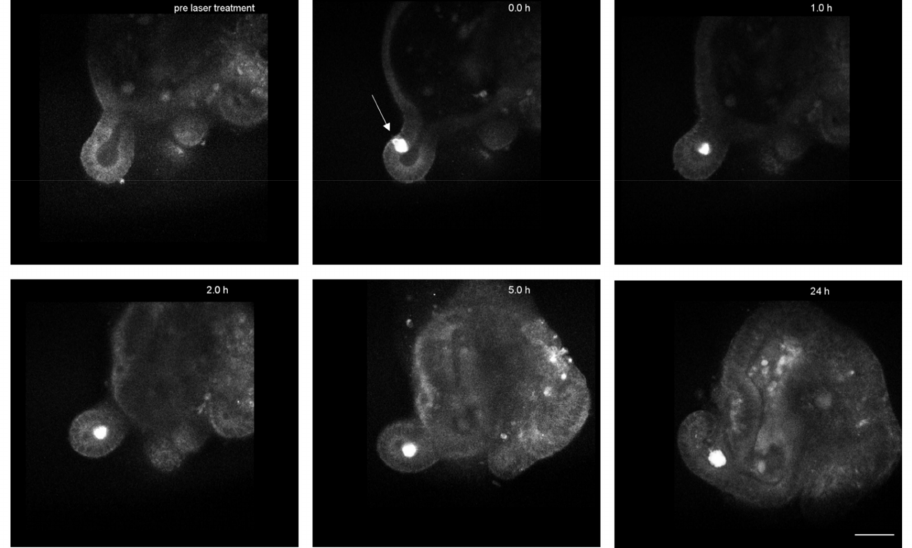
Figure A2. Time series of a single cell ablation in an unstabilised colonoid. The ablation site is labeled with a white arrowhead. One hour before cell ablation, the treated samples were removed from the BME, washed, and placed in a new dish to sink. In the progress of the regeneration and proliferation process, the morphology around the ablation site and throughout the colonoid changes significantly compared to stabilised colonoids. Scale bar corresponds to 50 µ